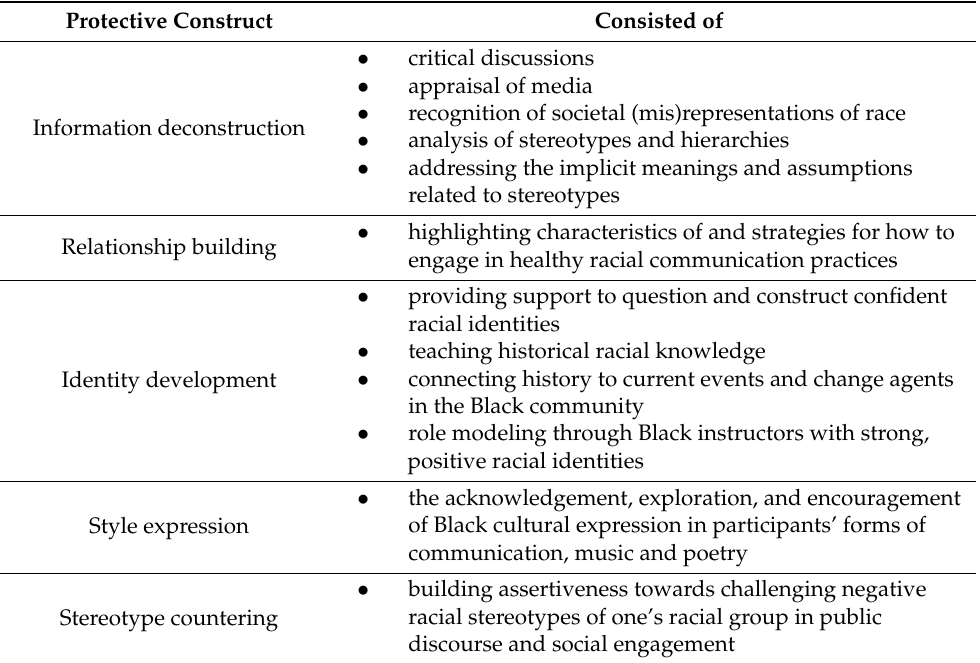
Table 1. Protective constructs introduced in Let’s